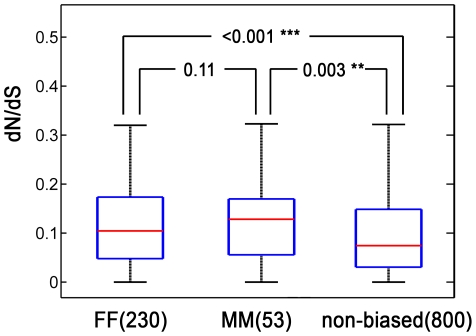
Non-synonymous versus synonymous substitutions in human and mouse sex-biased genes.Shown is a box plot of dN/dS ratios of common male-biased, female-biased and non-sex-biased genes between human and mouse. Numbers in parenthesis indicate the number of genes in each set. Common sex-biased genes that show consistent sex-bias in both human and mouse liver (MM and FF) had dN/dS ratios significantly higher than non-sex-biased genes (median of male-biased genes = 0.128, median of female-biased genes = 0.104, median of non-sex-biased genes = 0.074). Permutation p-values are indicated by **p<0.01 and ***p<0.001. The median dN/dS ratio for common male-biased genes was not significantly different than for female-biased genes (permutation p-value = 0.11).